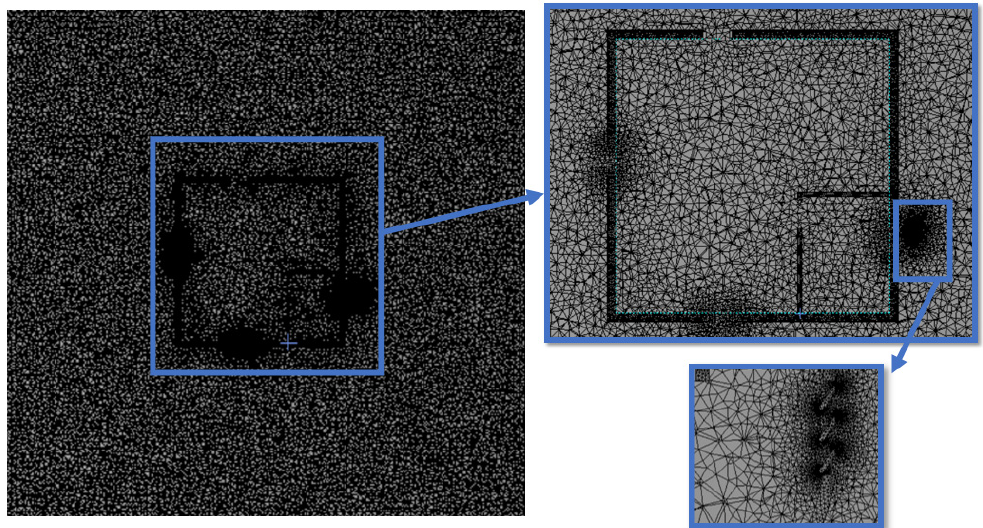
Figure 6. CFX mesh of the CAD model presented in Figures 2 and 3 (building and window-windcatcher).